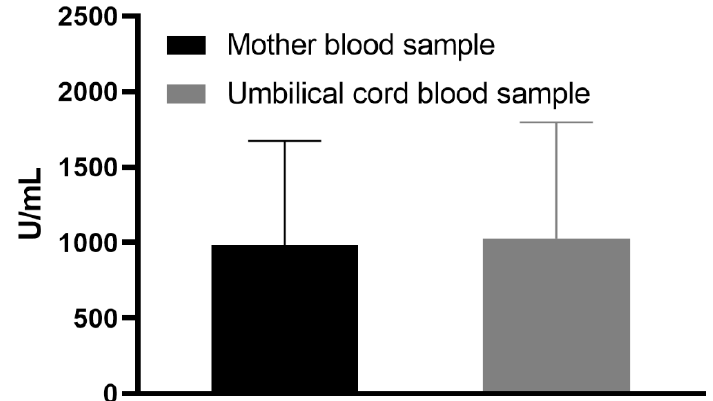
Figure 2. Mean anti-S antibody titers in maternal and umbilical cord blood.